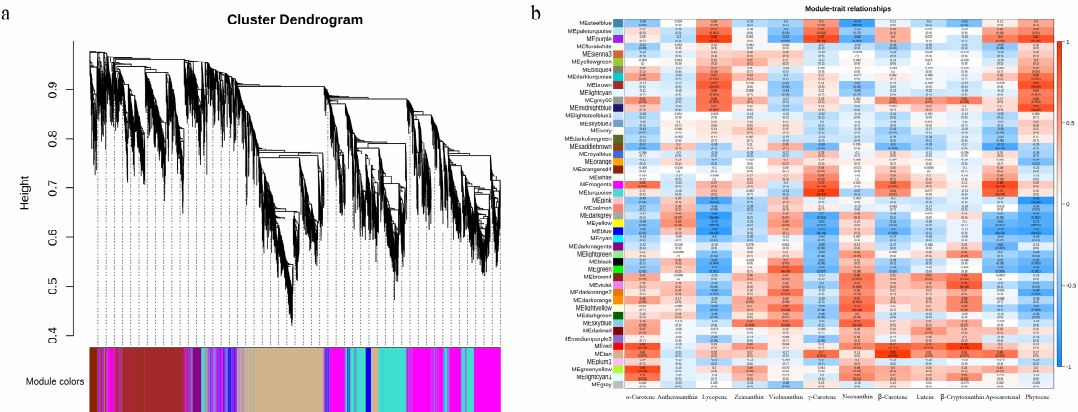
Figure 3. Transcriptomic and metabolic correlation analysis in turnip. ( a ) Forty-eight co-expression modules identified by weighted gene co-expression network analysis. ( b ) The heatmap of module- carotenoid